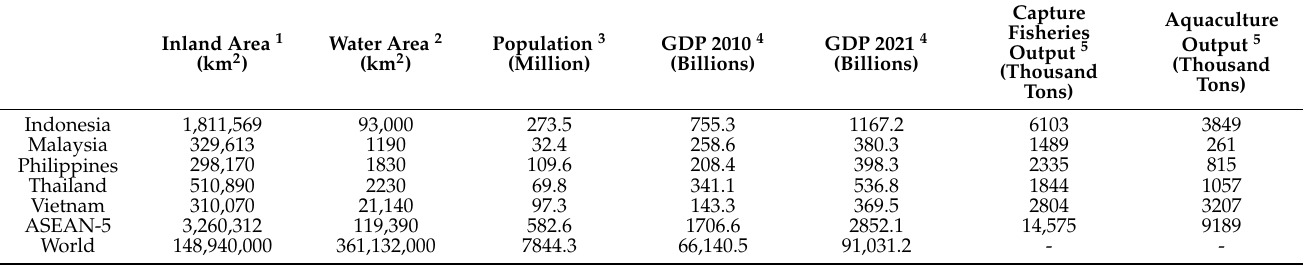
Table 1. Comparison of geographical areas, population, and gross domestic product (GDP) in the ASEAN-5